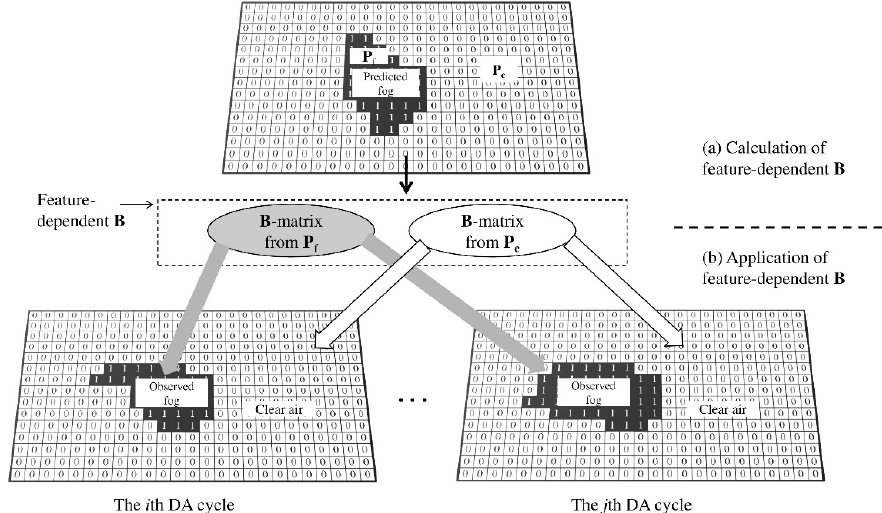
Figure 4. Schematic diagrams of the ( a ) calculation and ( b ) application of the feature ‐ dependent B ‐ matrix. In ( a ), a bidimensional geographical mask defined by the background ensemble is required to calculate the feature ‐ dependent B ‐ matrix, including B ‐ matrices from P f and P c , which correspond to the foggy areas and clear air in the background, respectively. Based on this mask, P f represents the sea fog bin consisting of the points labeled as 1, and P c indicates the clear ‐ air bin consisting of the points labeled as 0. During the DA update in ( b ), the same feature ‐ dependent B ‐ matrix is applied in all DA cycles. In each cycle, the other geographical mask provided by the observed sea fog distributions is used to apply error statistics from different bins at appropriate locations. See texts for the details.